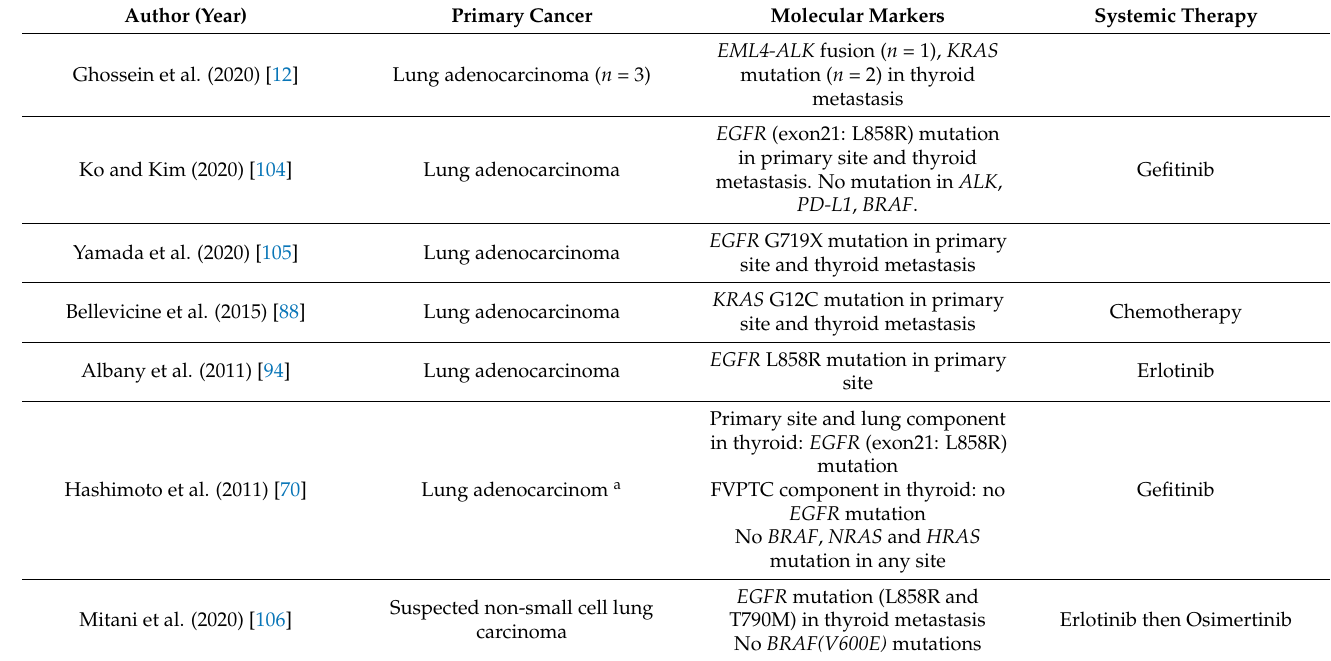
Table 5. Molecular markers of secondary thyroid cancer cases published in